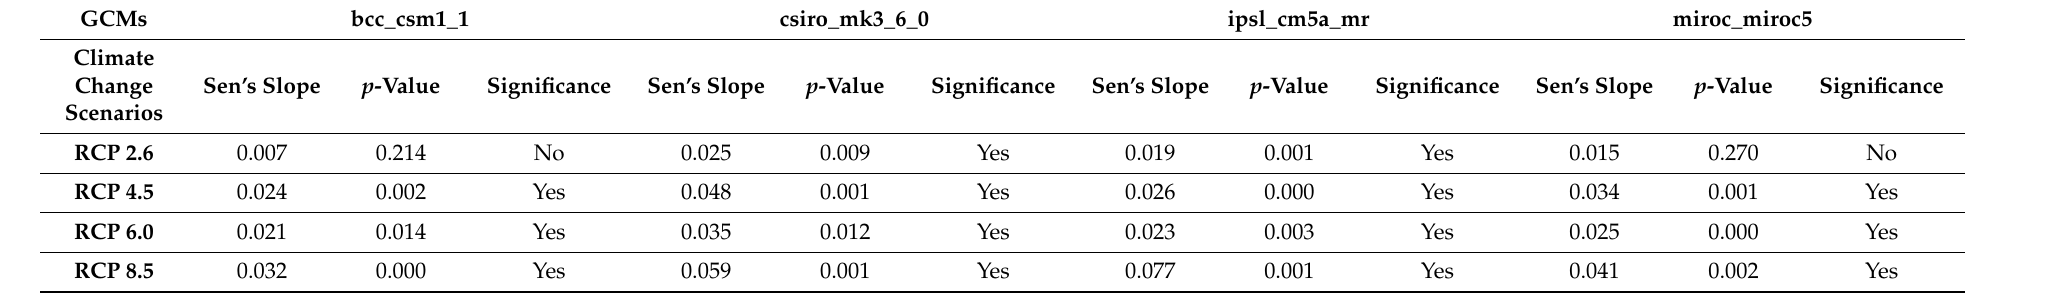
Table 3. Mann–Kendall trend test for minimum annual temperature (2020–2059) with all the four climate change scenarios.